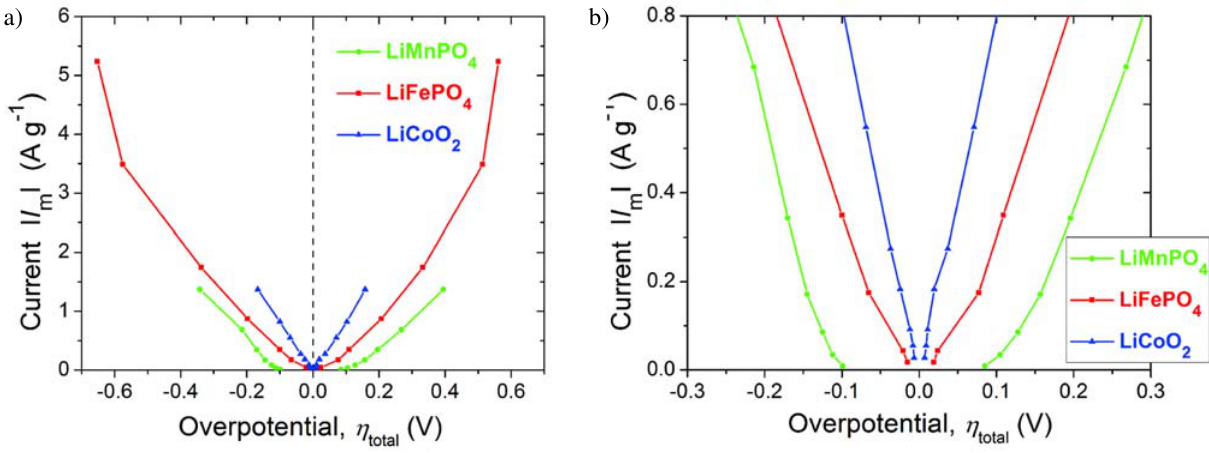
Figure 4. Current-Overpotential ( I – η ) characteristics of the compared LMP (green), LFP (red) and LCO (blue) obtained using the inflection m total point criterion together with Eq. 3. Data in panel (b) are merely a magnification of data in panel (a) for low current values. The data were extracted from the 3 sets of galvanostatic curves shown in Fig.